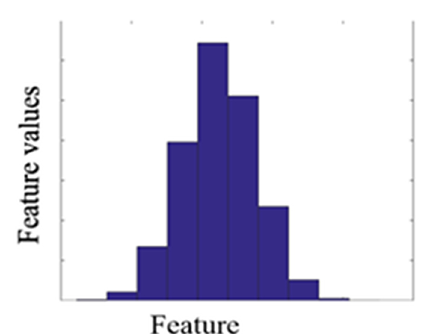
Figure 6. Normal distribution for one feature after generating the virtual